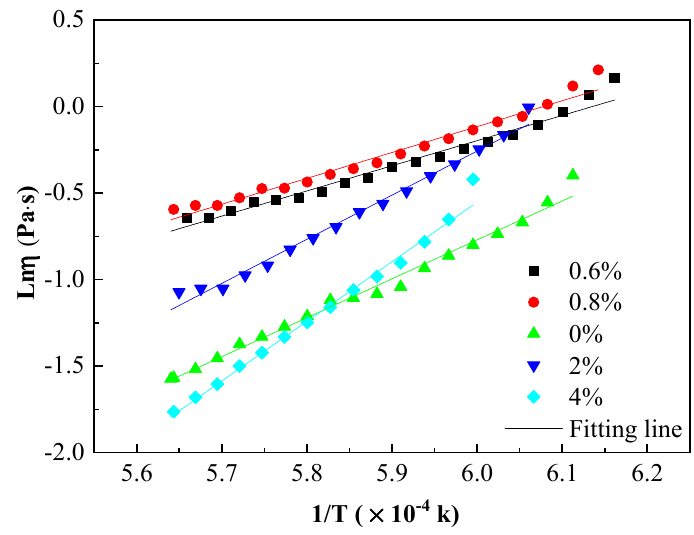
Figure 8. The relationship between ln η and 1/T. Table 3. Dynamics parameters of the viscous flow activation energy.